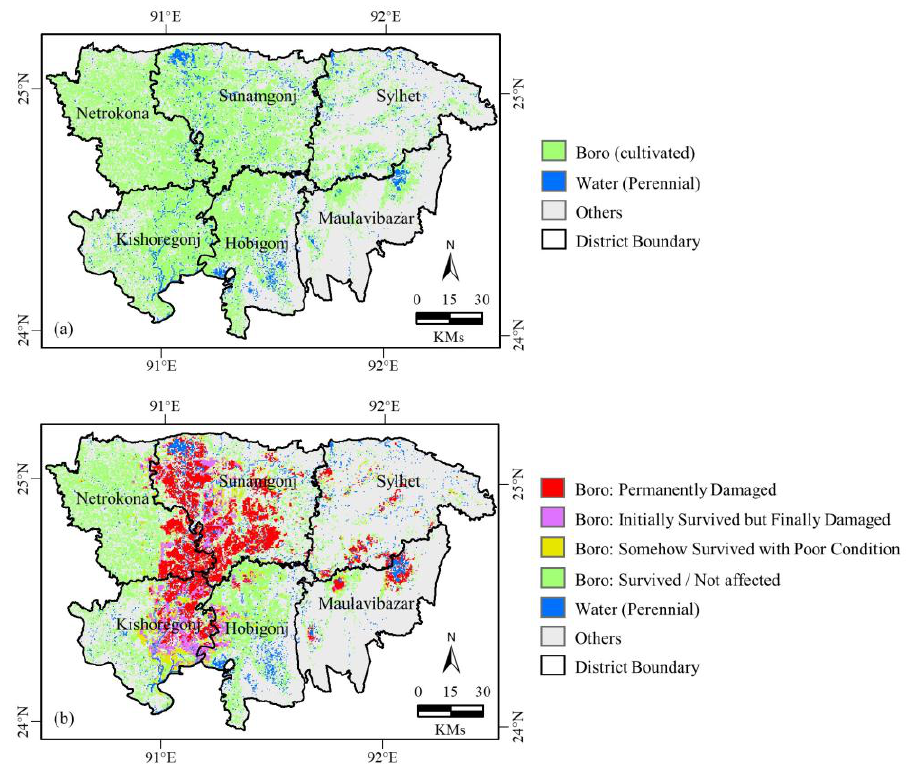
Figure 7. Spatial extent of: ( a ) cultivated boro derived from Landsat-8 OLI images during the pre-flash flooding time period, and ( b ) damaged boro derived from MODIS images due to the flash flooding event. Also, the cumulative area under all the four boro conditions as depicted in panel ( b ) were, in fact, same as the cultivated boro rice acreage estimated using Landsat-8 data as shown in panel ( a ).